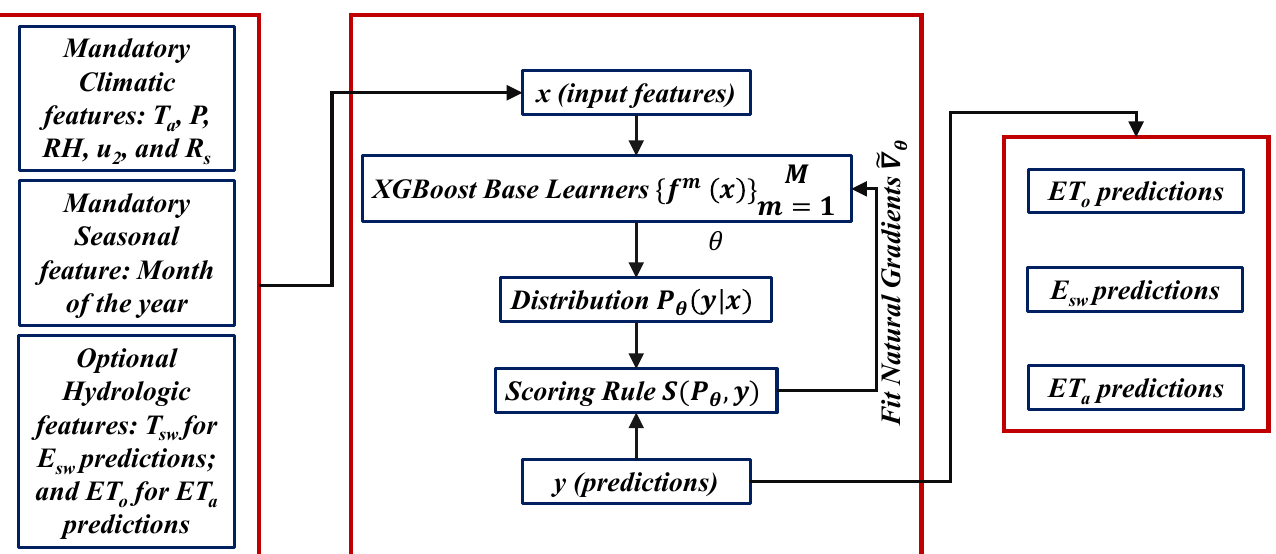
Figure 2. Conceptual representation of the hybrid NGBoost-XGBoost model for ET o , E sw , and ET a